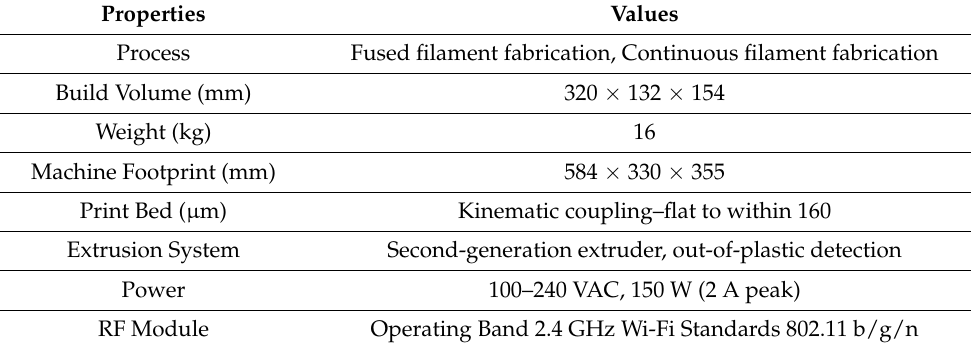
Figure 2. 3D printer. ( a ) drawing and details, ( b ) photograph. Table 1. Mark two 3D printer